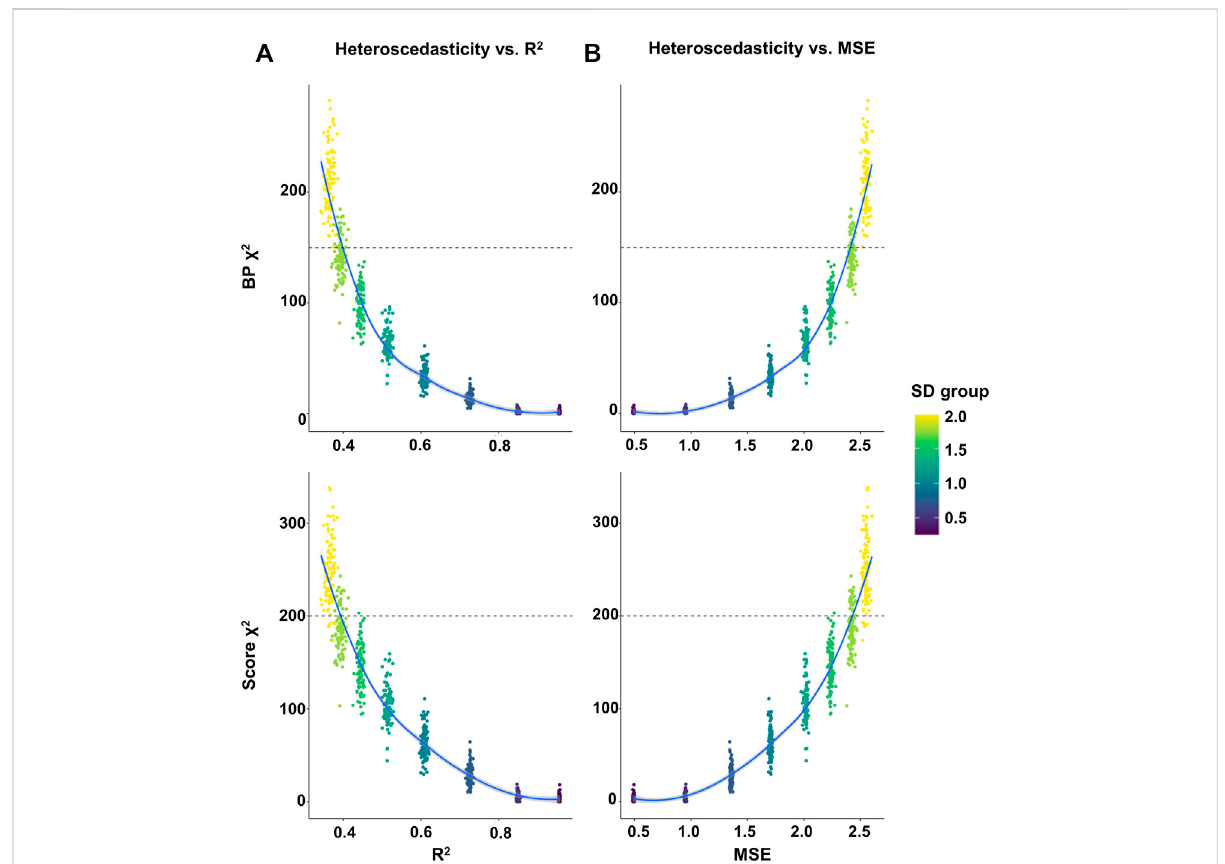
FIGURE 3 Plot of the heteroscedasticity versus the prediction accuracy of GPS in randomly selected samples. Linear regression analyses on GPS were performed using randomly selected samples with various SD cutoffs (from 0.25 to 2 by 0.25 increment) in the UKB validation set. The random selectionof10,000sampleswererepeated100timesandeachsamplewasusedforalinearregressionanalysis. (A,B) Theheteroscedasticity( χ 2 ofBP in the upper panel and Score test in the lower panel) in each sample was plotted against the prediction accuracy ( R 2 in A and MSE in B) of